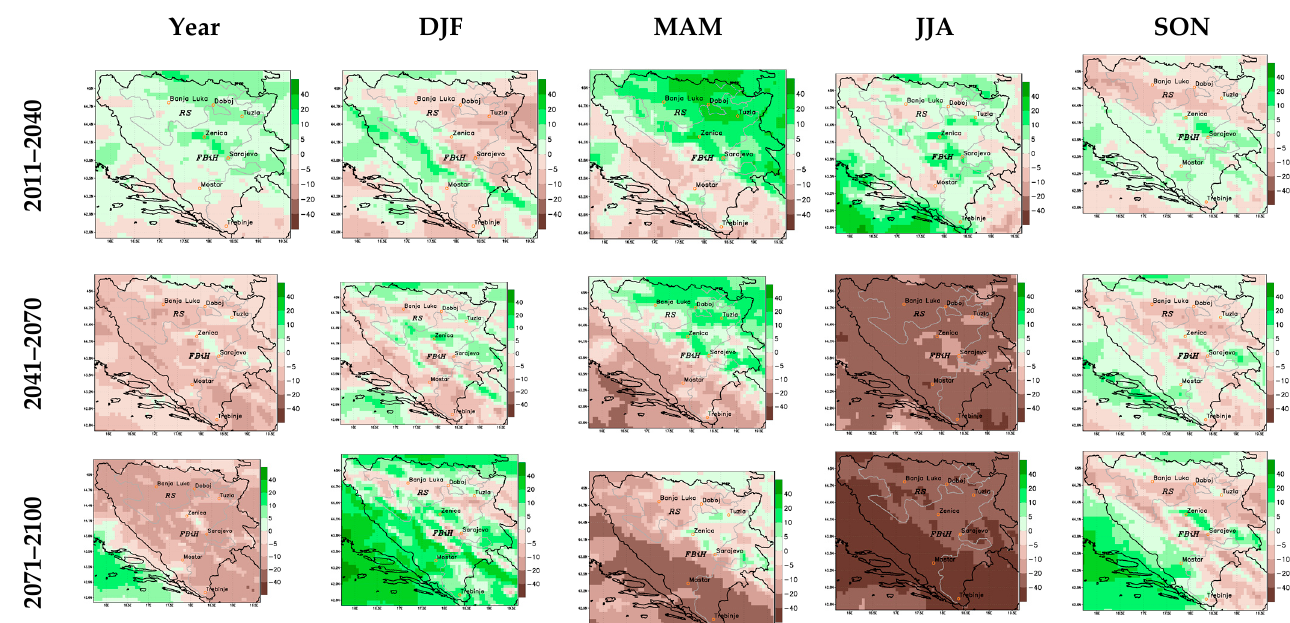
Figure 3. Change in mean seasonal (DJF, MAM, JJA and SON) and annual accumulated precipita- tion in %, for the periods 2011–2040, 2041–2070 and 2071–2100 compared to the period 1971–2000, according to the future climate scenario RCP8.5.